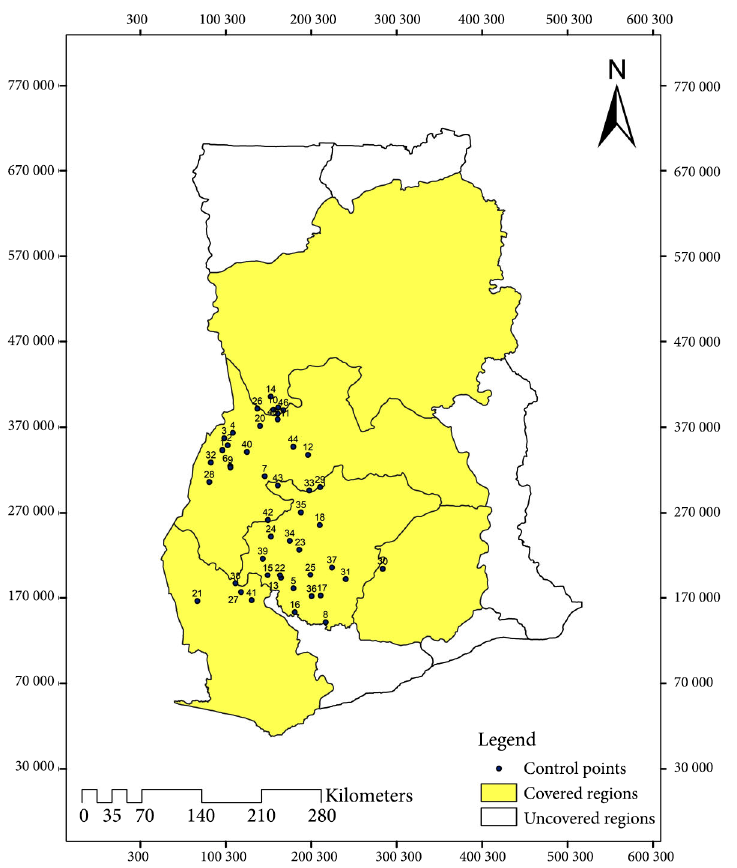
Figure 1. Study area: distribution of data